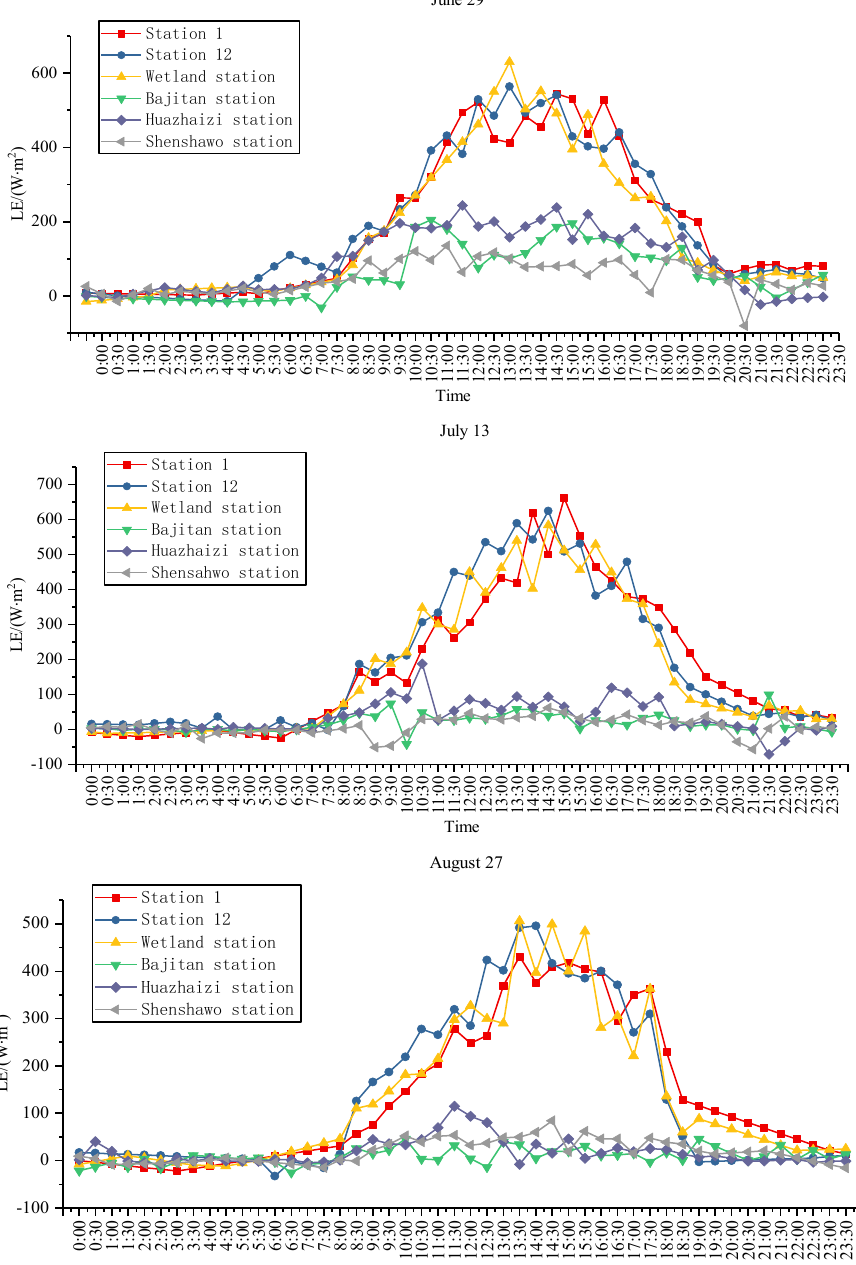
Figure 7. LE intraday variation trend under different pad types on June 29, July 13 and August 27. Table 3. The correlation coefficients of LE and influencing factors under different underlying sur- face types.